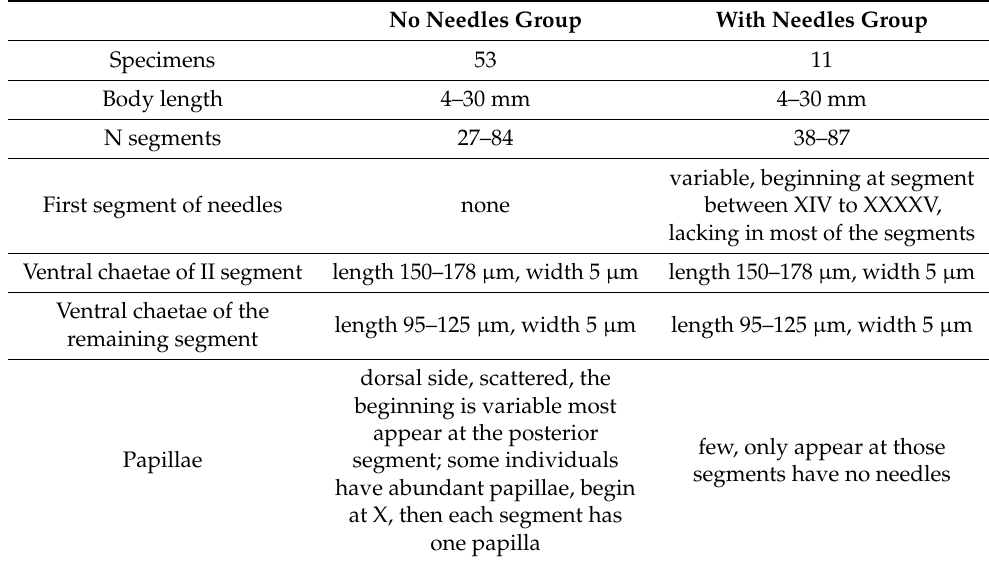
Table 1. Comparison for two morphological groups of